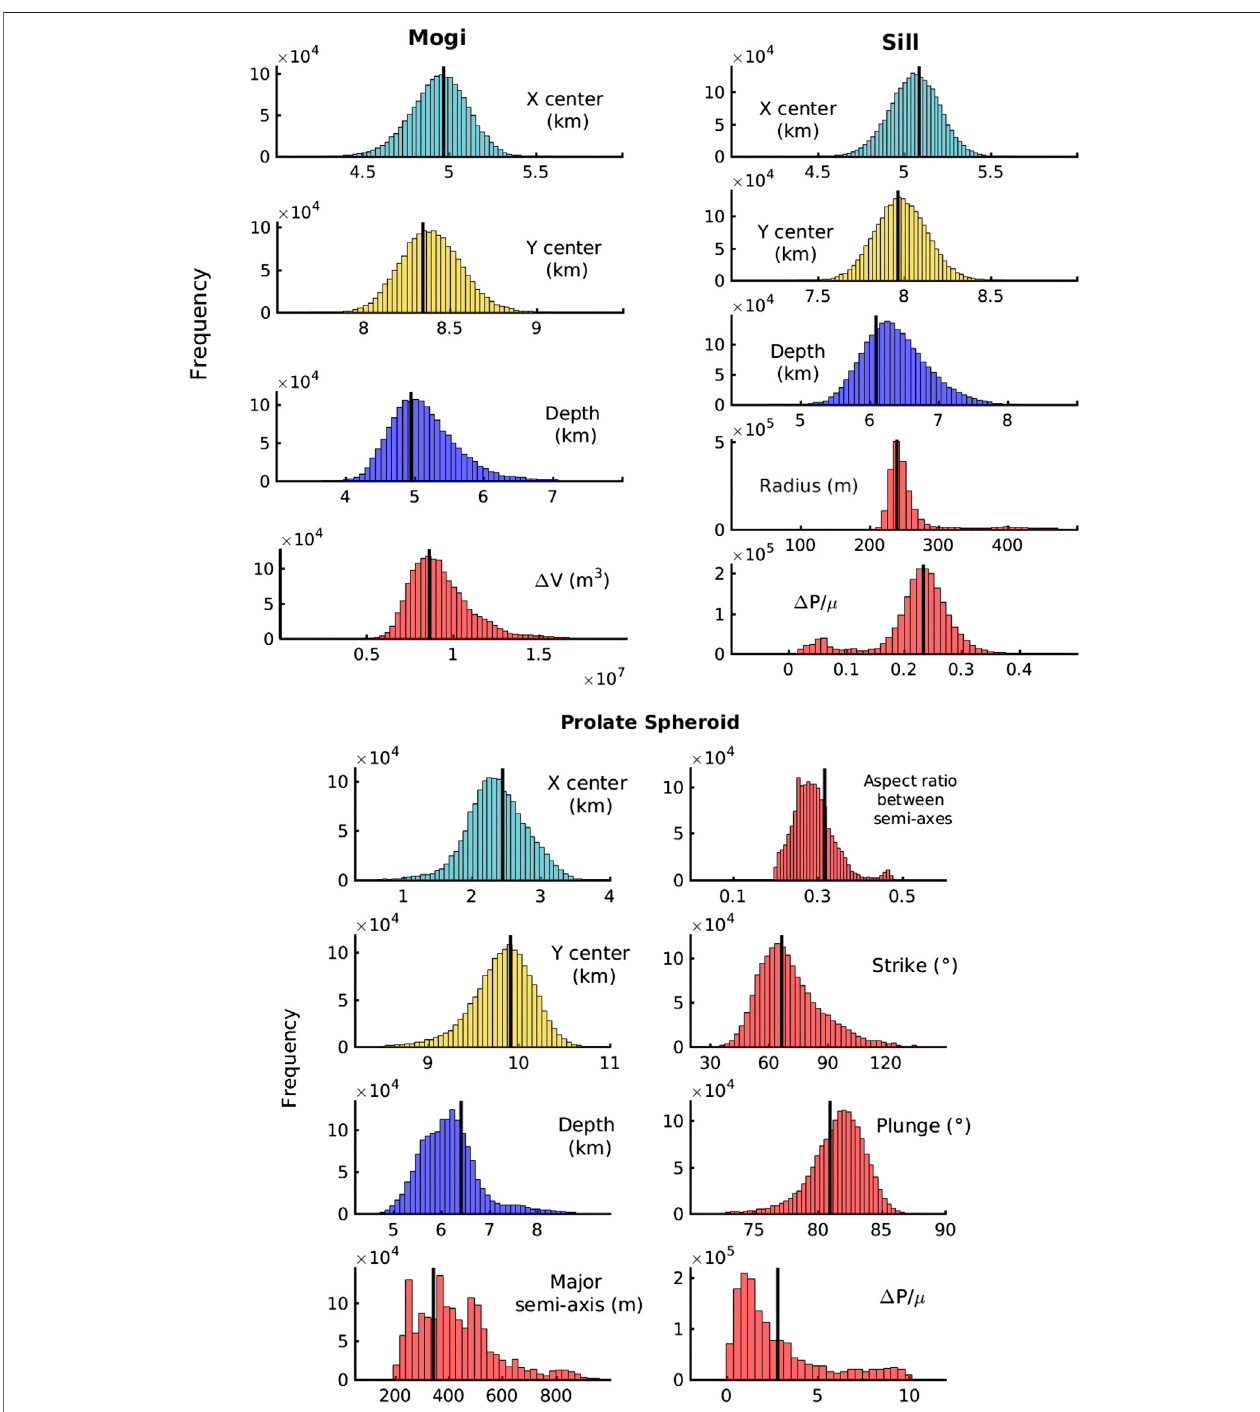
FIGURE 5 | Posterior probability distributions for the Mogi, sill-like and prolate spheroid source models. Black solid lines show the optimal value for the corresponding model parameter ( Tables 1 , 2 ).